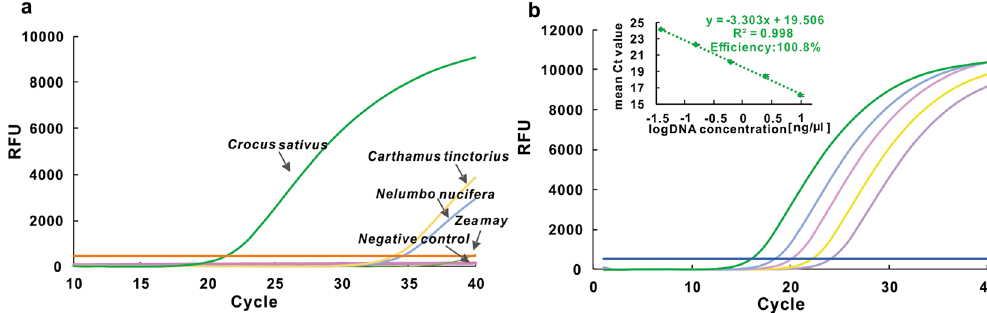
Figure 1. ( a ) Amplification plot generated by Crocus sativus and its possible adulterants. ( b ) Amplification plot and calibration curve generated by known concentration of saffron DNA